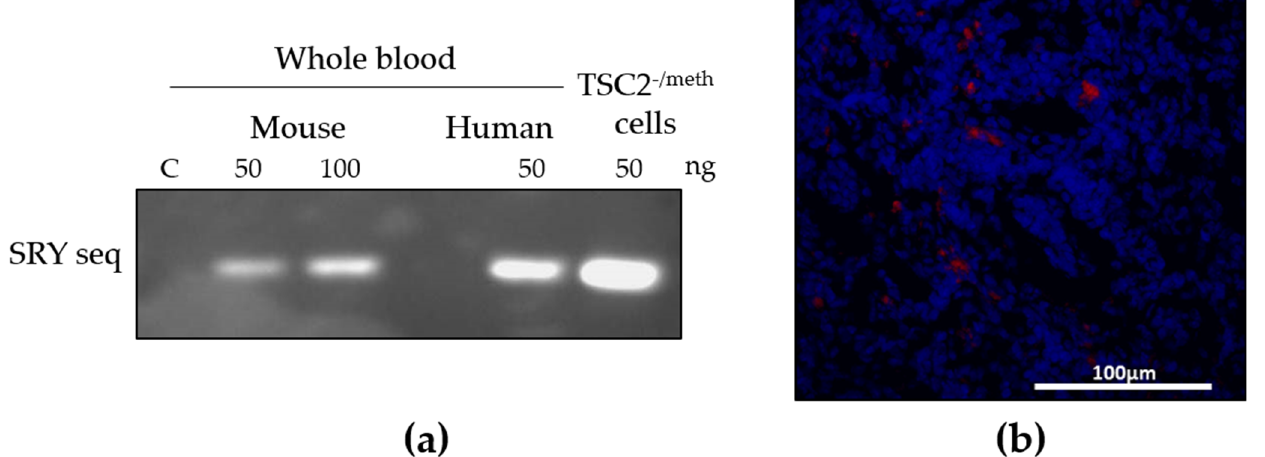
Figure 5. ( a ) Electrophoresis of 50 and 100 ng of PCR amplification product to detect human-specific SRY sequences in the whole blood of a mouse injected with TSC2 -/meth cells (Mouse); in the whole blood of a human male subject (Human); and in DNA extracted from TSC2 -/meth cells. C: negative control (C). ( b ) Representative images of lymph nodes section, 60 days after TSC2 -/meth cells injection. Red fluorescent PKH26-positive cells were detected; nuclei were stained with DAPI. Scale bar: 100 µm.